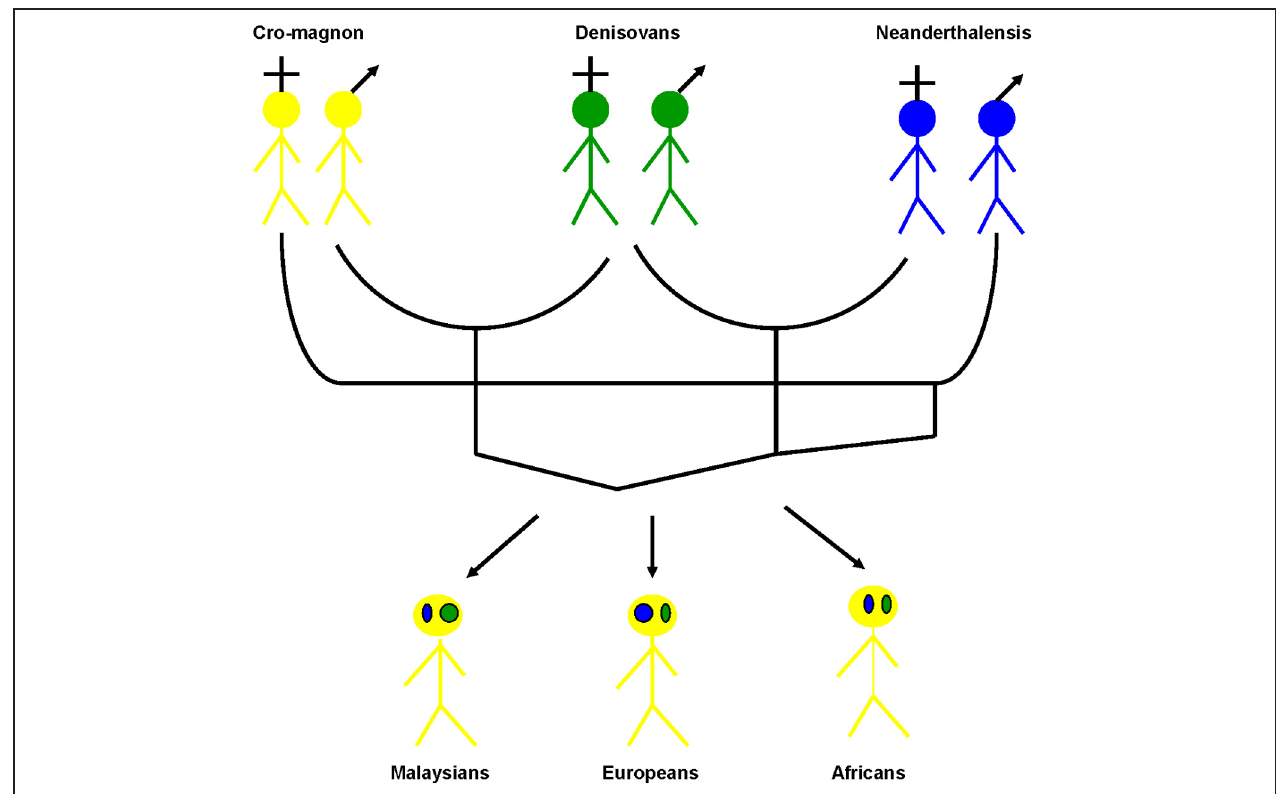
FIGURE 1 | The human rhizome. The current human genome harbors genes acquired vertically, predominantly from Cro-Magnon ancestors but also from Denisovans and Neanderthals. In addition to the Cro-Magnon genes,